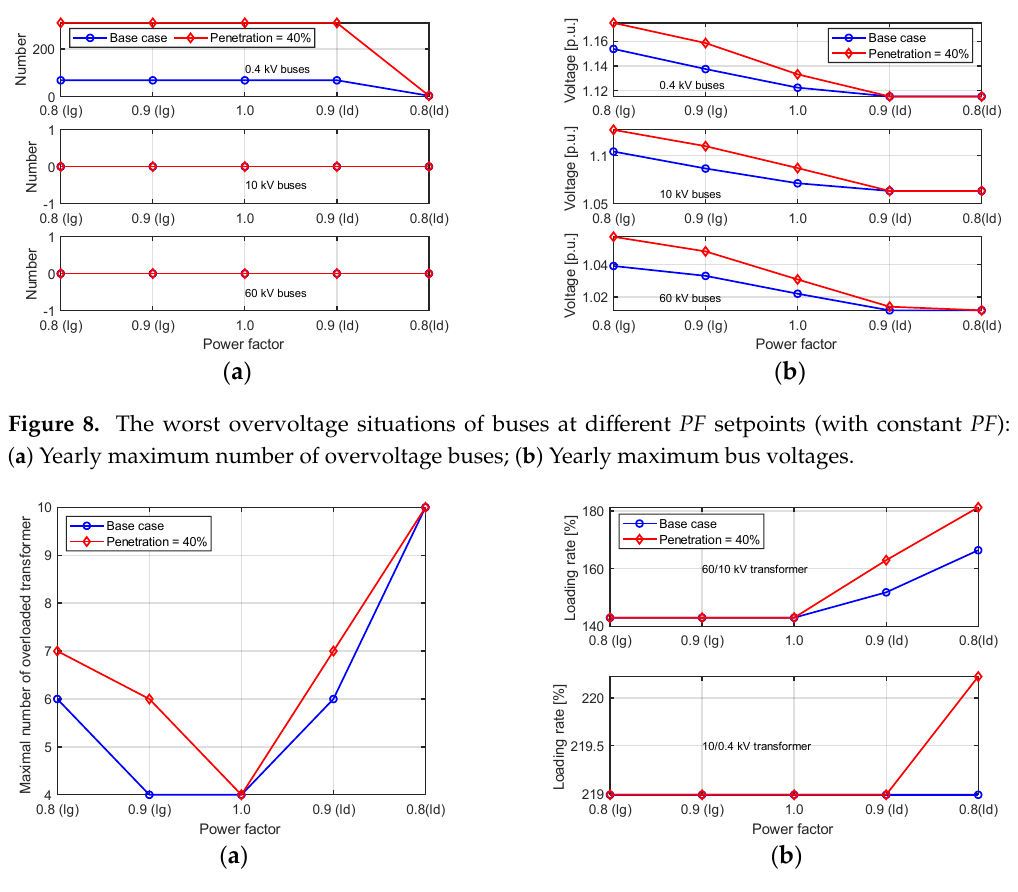
Figure 9. The worst overload situations of transformers at different PF setpoints (with constant PF ): ( a ) Yearly maximum number of overloaded transformers; ( b ) Yearly maximum loading rate of the transformer.